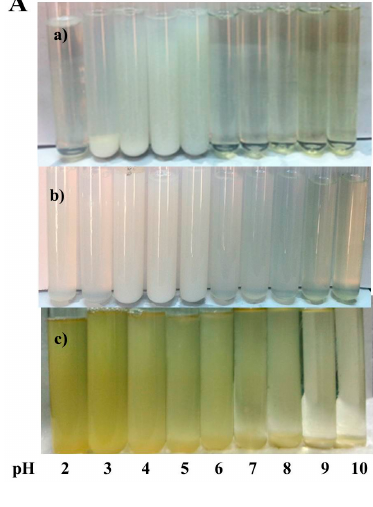
Figure 7. Cont. Figure 7.